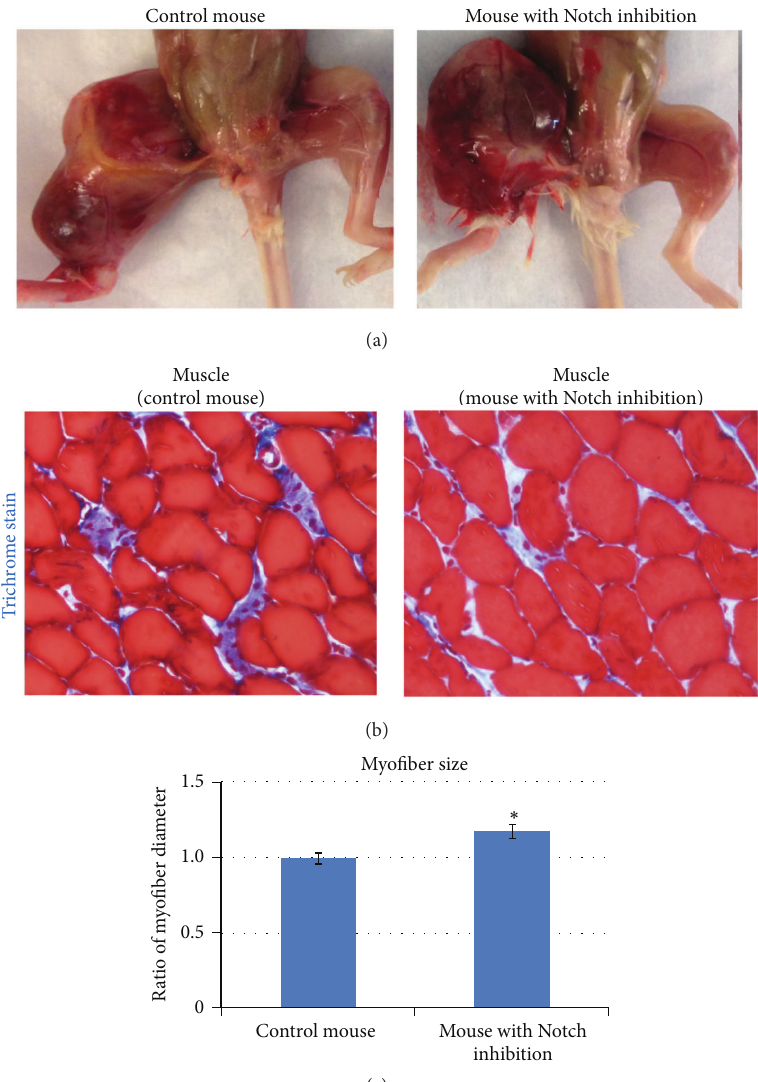
Figure 4: In vivo inhibition of Notch signaling in tumor-bearing mice reduced skeletal muscle atrophy. (a) Notch inhibitor MK-0752 (50 mg/kg) was injected starting two weeks after K7M2 cell injection, three times a week for four weeks. The size of the primary osteosarcoma tumor was unaffected by MK-0752 injection. 𝑁 = 4 mice in each group. (b) Trichrome staining showing decreased fibrosis formation in muscles with Notch inhibition. (c) Differential myofiber size with and without MK-0752 injection. “ ∗ ” in the bar chart indicates 𝑃 < 0.05